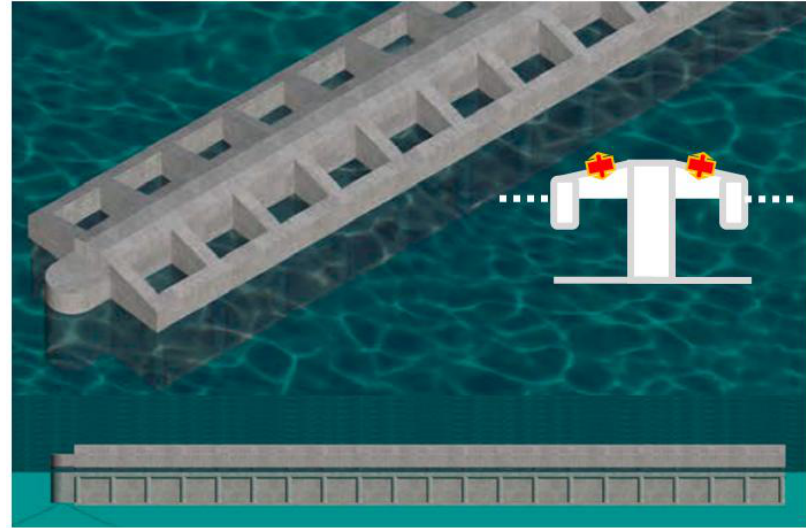
Figure 1. The conceptual design of the KNSWING.